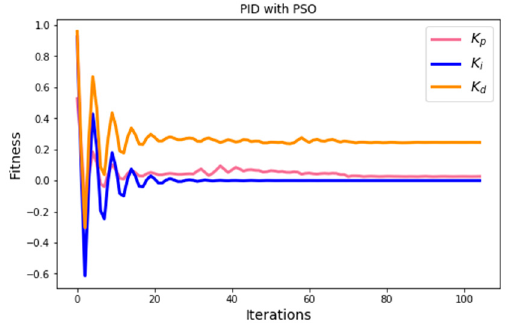
Figure 4. Response of X ( K p , K i , K d ) with Particle Swarm Optimization (PSO).